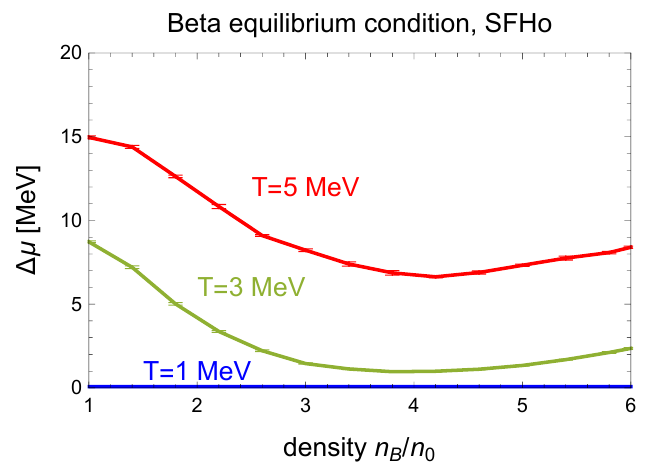
Figure 7. Nonzero-temperature correction ∆ µ required for beta equilibrium Equation (7) with the SFHo